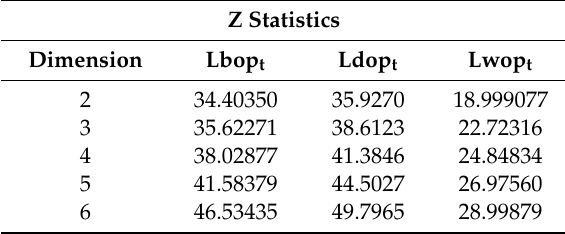
Table 2. Brock–Dechert–Scheinkman (BDS) test results. Z